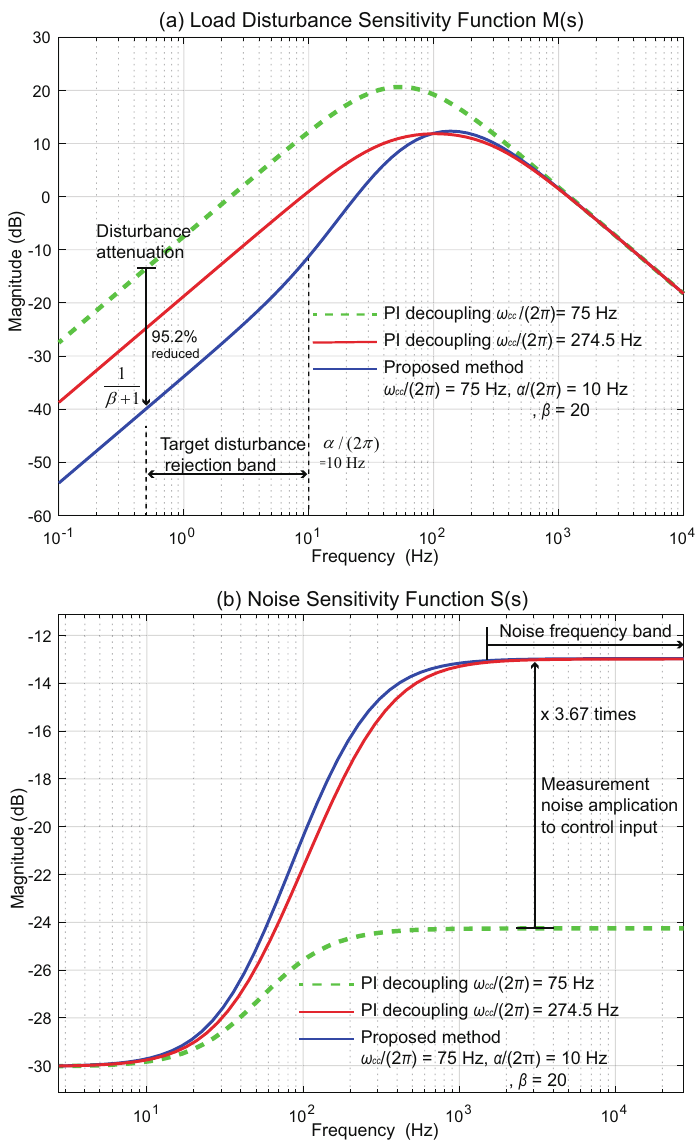
Figure 5. Comparison of q -axis ( a ) load disturbance sensitivity and ( b ) noise sensitivity